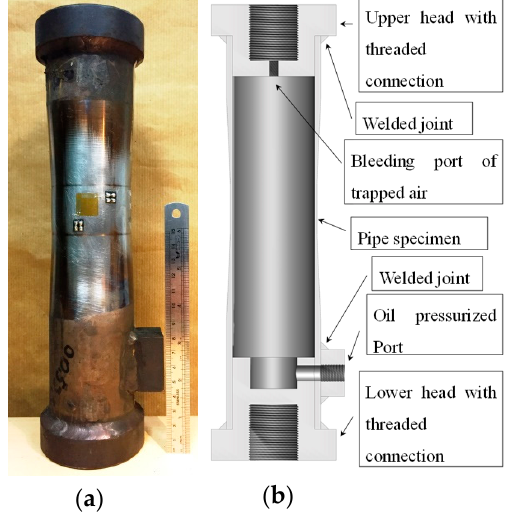
Figure 3. Biaxial loading test sample: ( a ) external view ( b ) internal view.